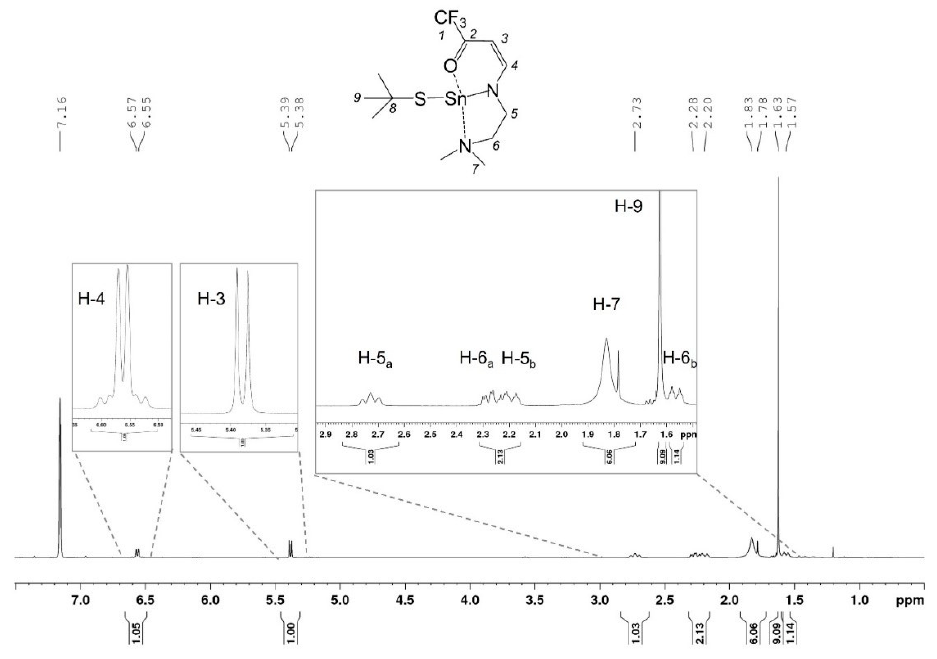
Figure 2. 1 H-NMR spectrum of 1 in C 6 D 6 recorded at 400 MHz .